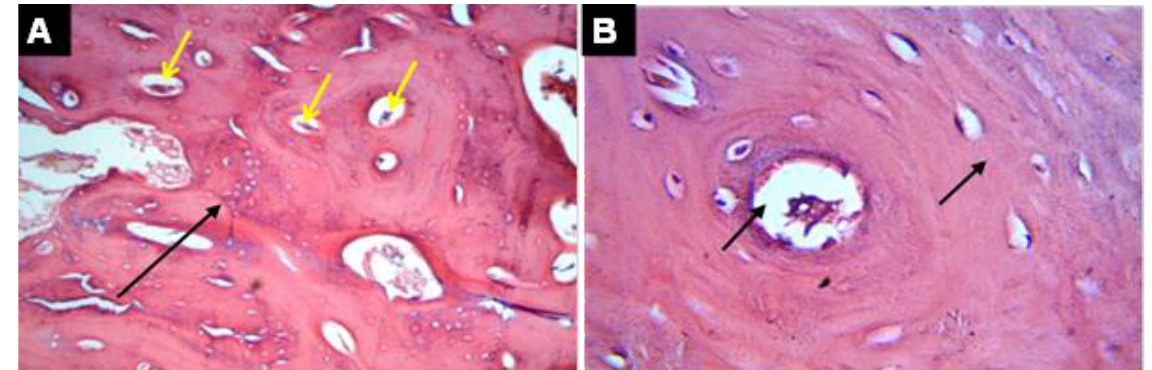
Figure 8. Histopathological section in treated group at 12 th weeks post-operation, (A) Thick trabecular bone extended from the site of defect bone (arrow) (B) compact bone attached to the site of defect bone (arrow) (H and E,